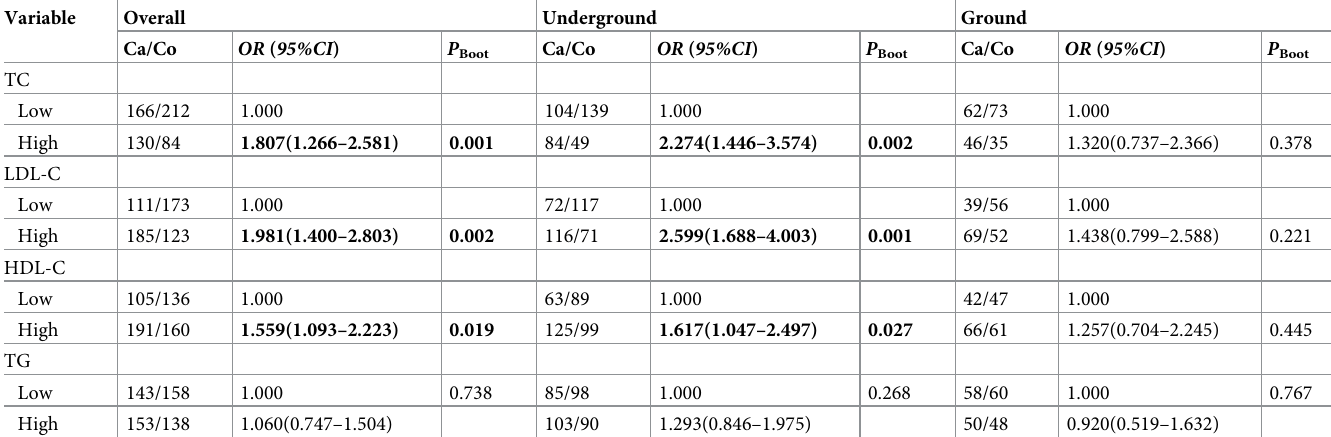
Table 4. Association of hypertension risk with TC, LDL-C, HDL-C, and TG. Variable Overall